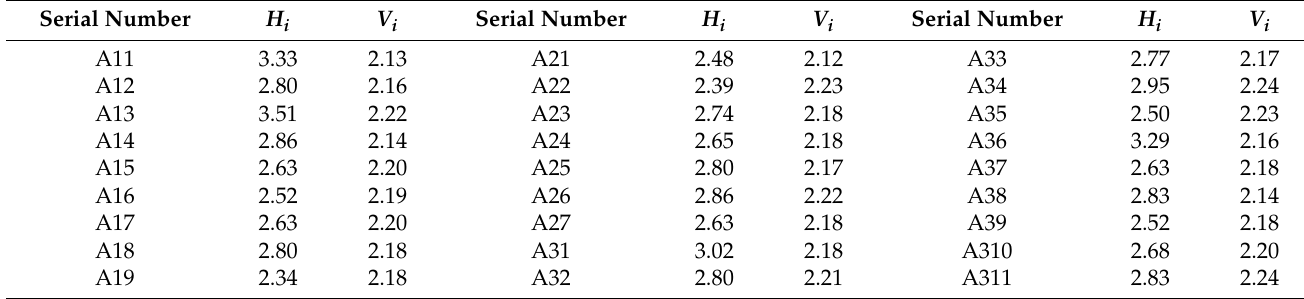
Table 4. User demand importance score table ( H i